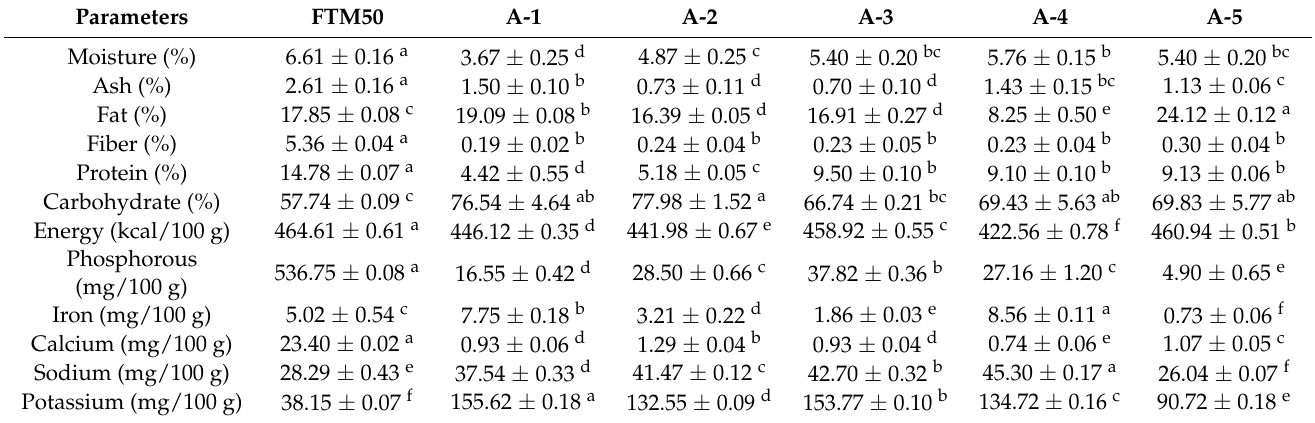
Table 5. Biochemical comparison of the FTM50 and commercial noodles 1